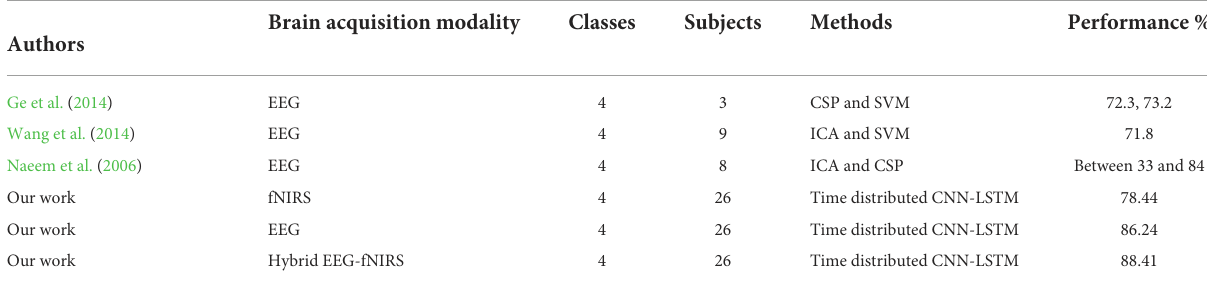
TABLE 2 Comparison with other 4-class classification studies for BCI.